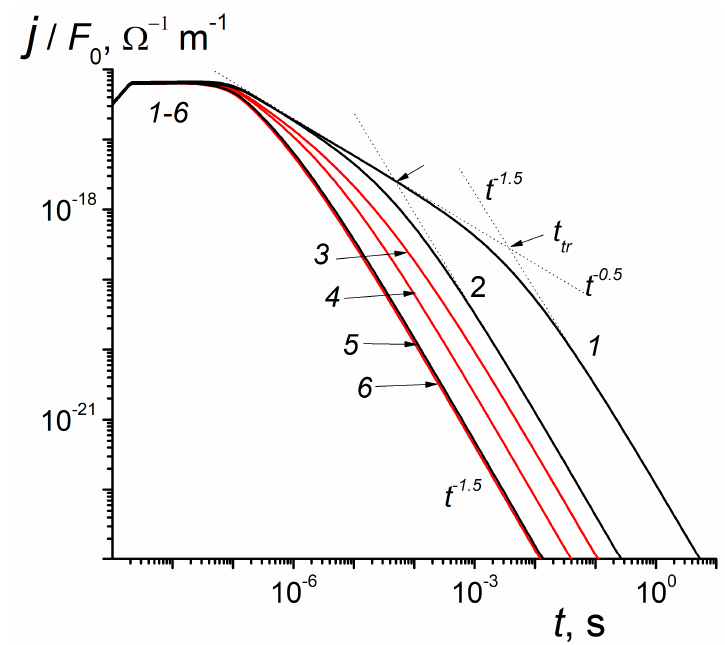
Figure 1. Computed time-of-flight (TOF)-2 curves for a prototype polymer reduced to a unit electric field. Pulse length 2 ns, film thickness 2.5 µ m. τ c = 5.4 × 10 3 s (1,2,5, black) and τ c = 5.4 × 10 − 10 s (3,4,6, red); electric field 10 7 (1,3), 10 8 (2,4) and 10 9 V / m (5,6). For t ≤ 2 ns, results refer to radiation-induced conductivity (RICd) only. Also, g 0 = 10 20 m 3 · c − 1 and k rec is assumed zero. Note that curves (5) and (6) almost coincide.